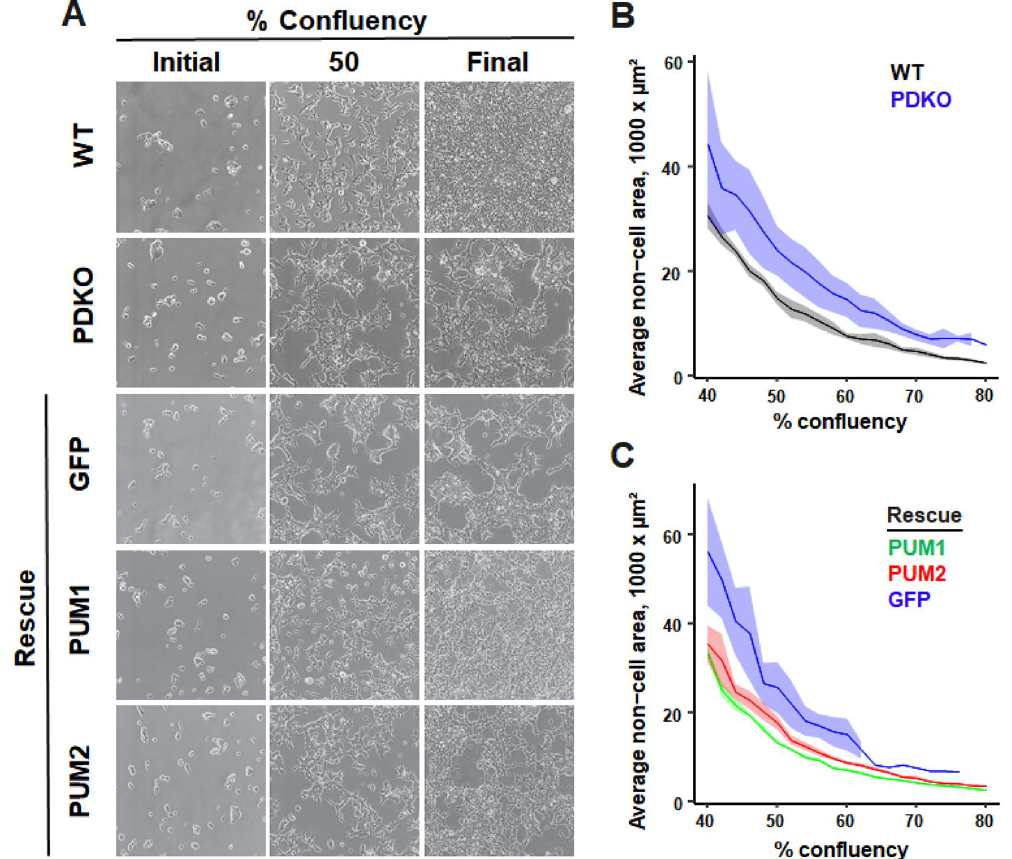
Figure 4. PDKO cells have cell–cell adhesion and separation defects. ( A ) Representative images of WT, PDKO, and rescue constructs at initial seeding, 50% confluency, and final confluency ( B ) Quantification of non-cell area for WT and PDKO T-REx-293 cells by % confluency. Shaded regions represent standard error of the mean. ( C ) Stable integrant populations of PUM1 (green), PUM2 (red), or GFP (blue) in PDKO T-REx-293 cells were analyzed for average non-cell area. Shaded regions represent standard error of the